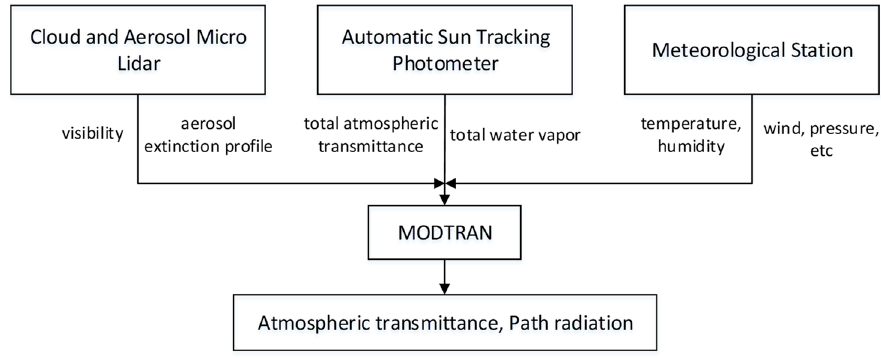
Figure 1. Workflow for MODTRAN software using measured atmospheric parameters.